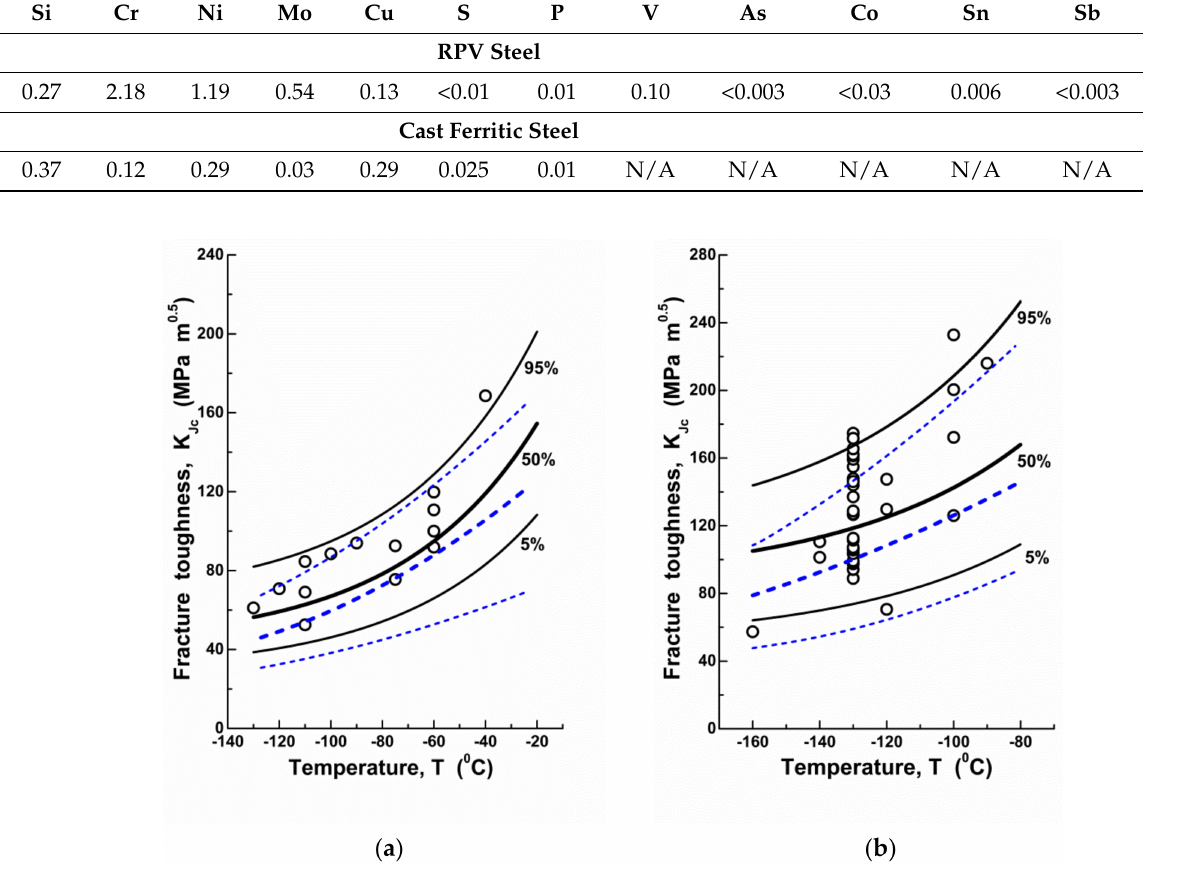
Figure 3. (Colour online). The temperature dependences of fracture toughness K Jc for RPV steel ( a ) and cast low-alloyed manganese steel ( b ): circles represent the experimental values; lines are the calculation results (solid black lines are the results of K Jc calculation accounting for temperature dependence for the CN density ρ , dashed blue lines are the same at the constant values of ρ